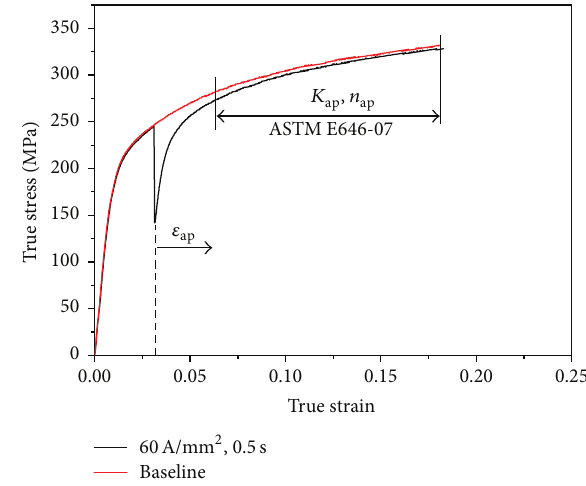
Figure 8: A definition of the true strain 𝜀 ap and the calculation of hardening parameters after the pulse of electric